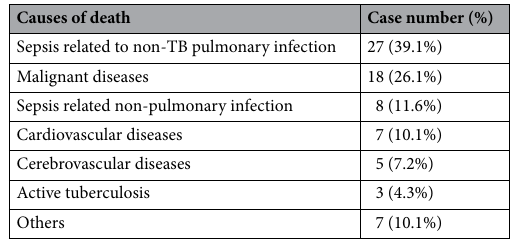
Table 2. Causes of death in PTB patients died before anti-TB treatment. Data are presented as n (%).